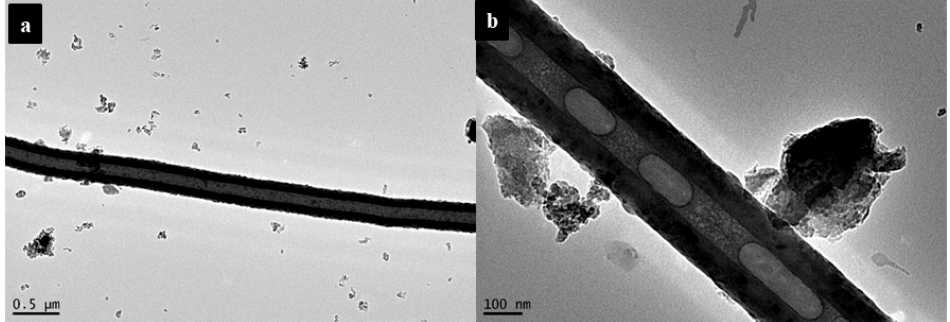
Figure 5. HR-TEM images of SL-CNTs synthesized at 1400 °C: ( a ) and ( b ) show different magnifications.